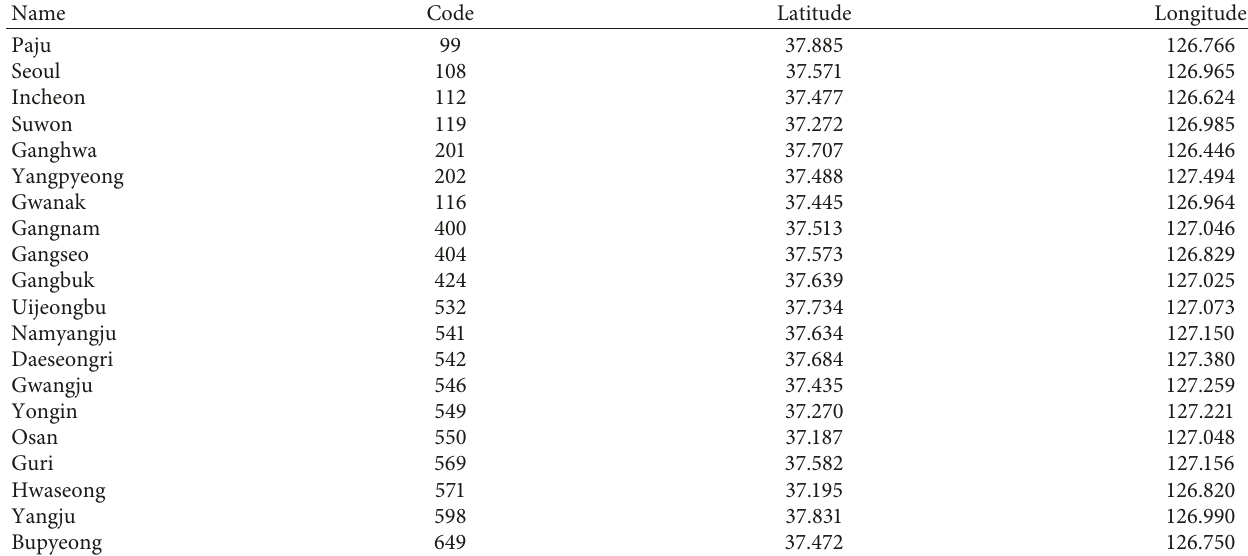
Table 1: Ground precipitation gauge stations selected for this study.